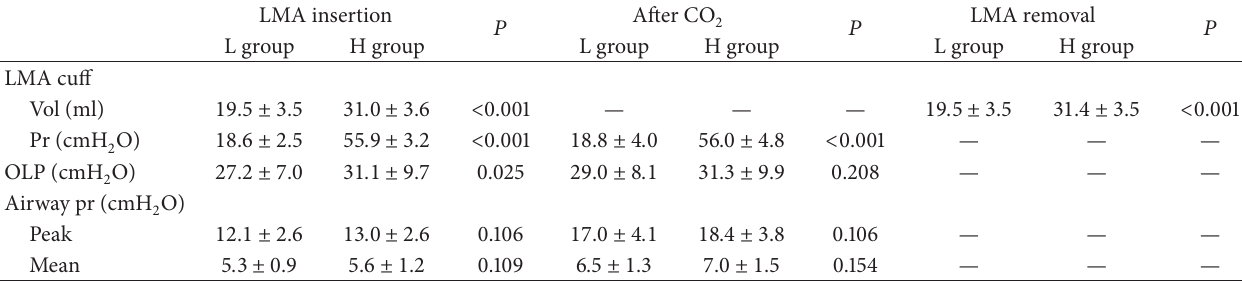
Table 2: Laryngeal mask airway (LMA) parameters compared between low and high LMA cuff pressures. LMA insertion